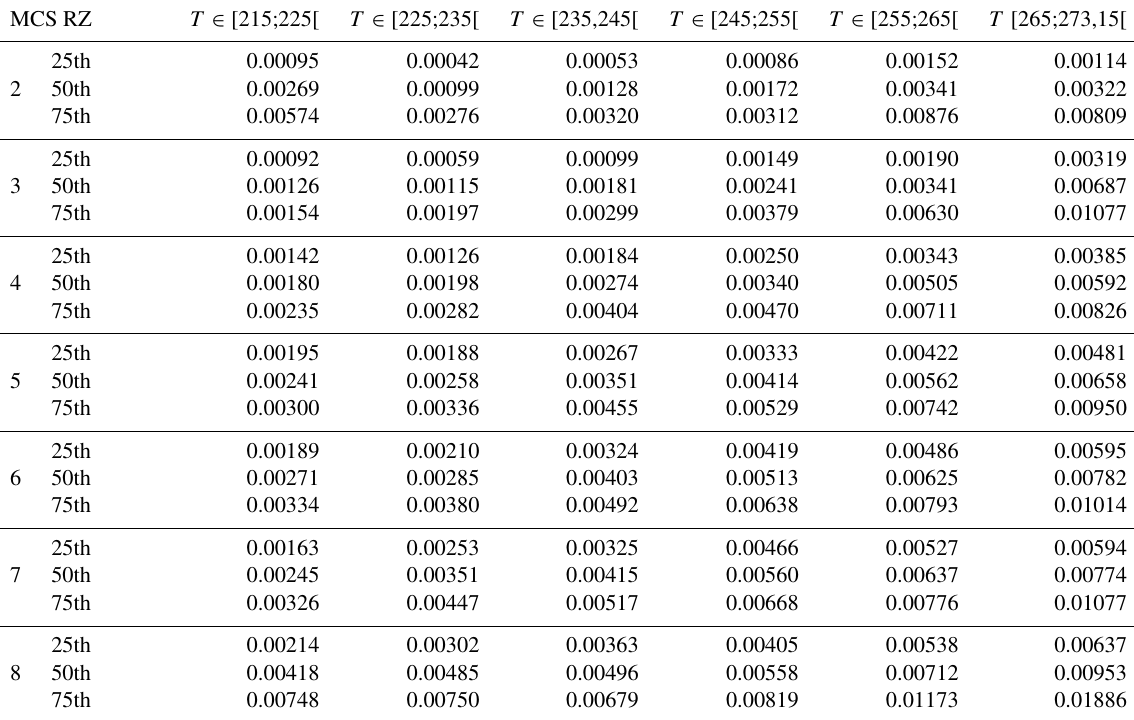
Table C7. Pre-factor α of mass–size relationship in g cm − β (Fig.